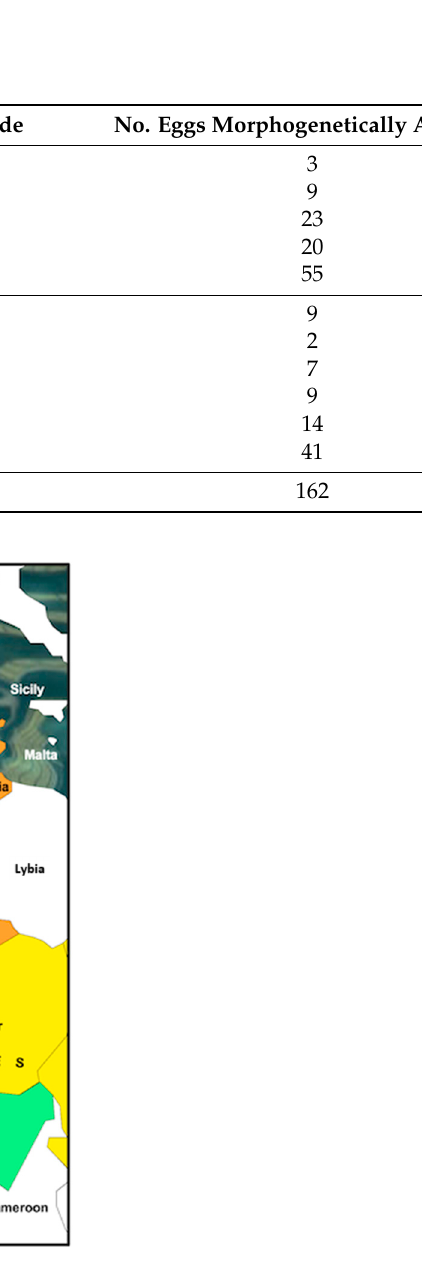
Figure 2. Countries of origin of migrants diagnosed in Spain (Almeria) with urinary schistosomiasis analyzed in this study. Red arrows represent country of origin and final destination.